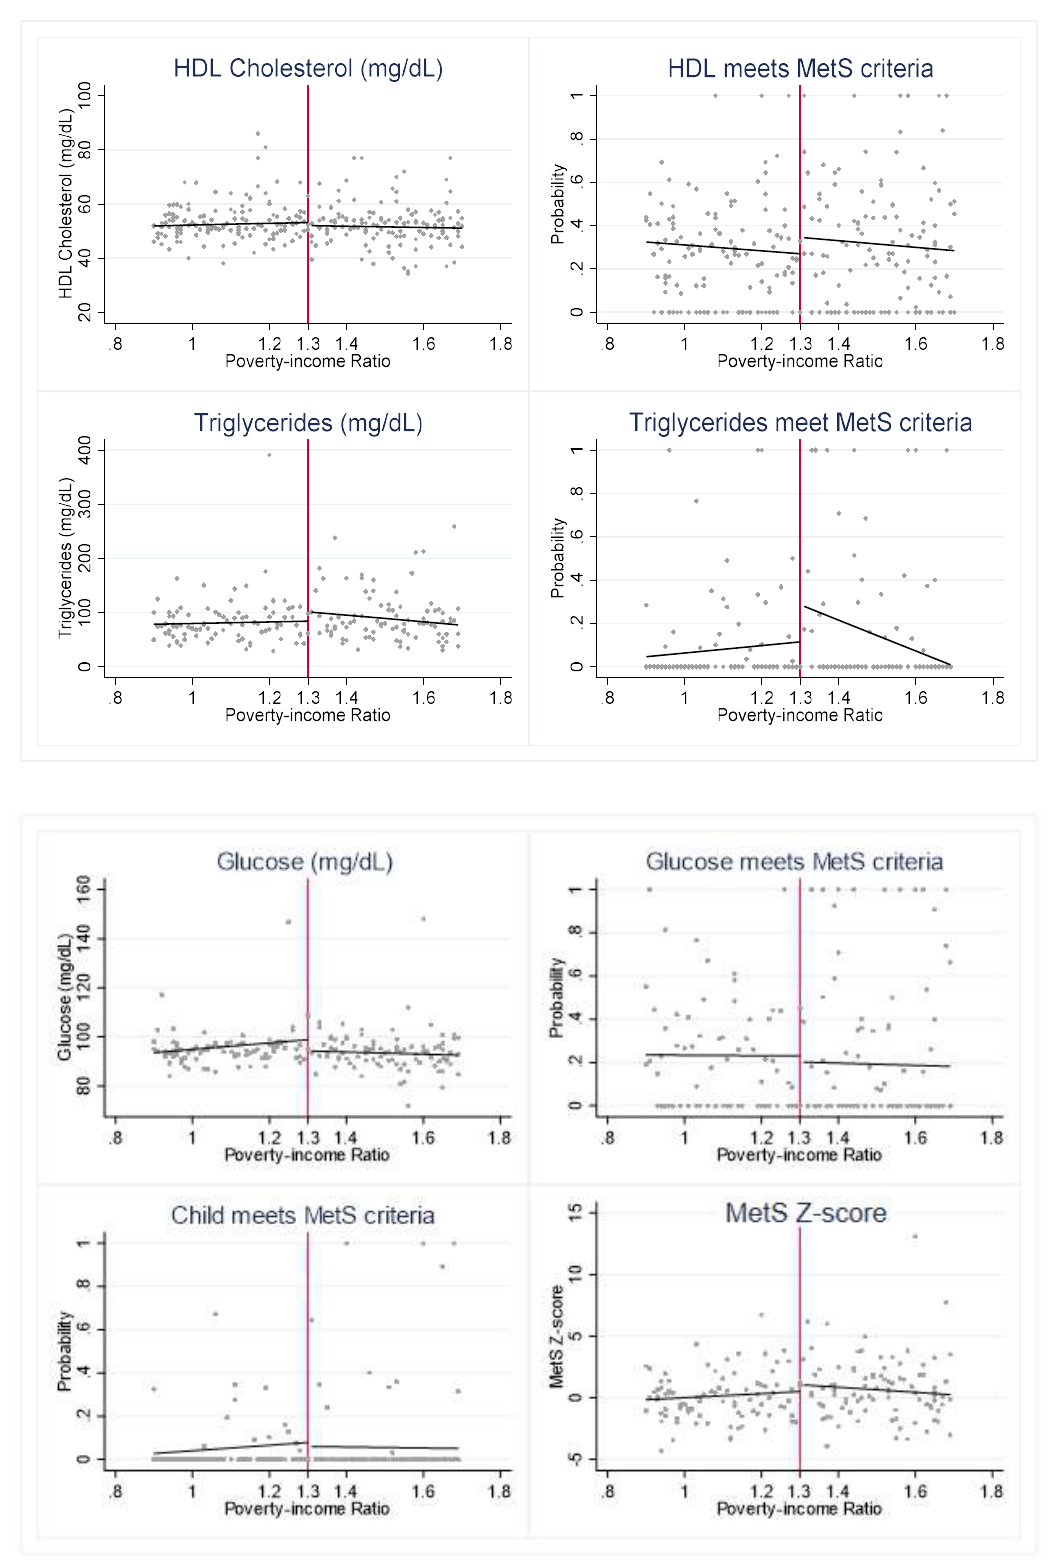
Figure 1. Cardiometabolic risk indicators around 1.30 poverty income ratio (PIR). Notes: Figure 1 presents the weighted, mean outcome of each cardiometabolic risk indicator across levels of PIR. The red vertical line indicates the federal SNAP income-eligibility criteria of gross household income at or below 1.30 PIR.